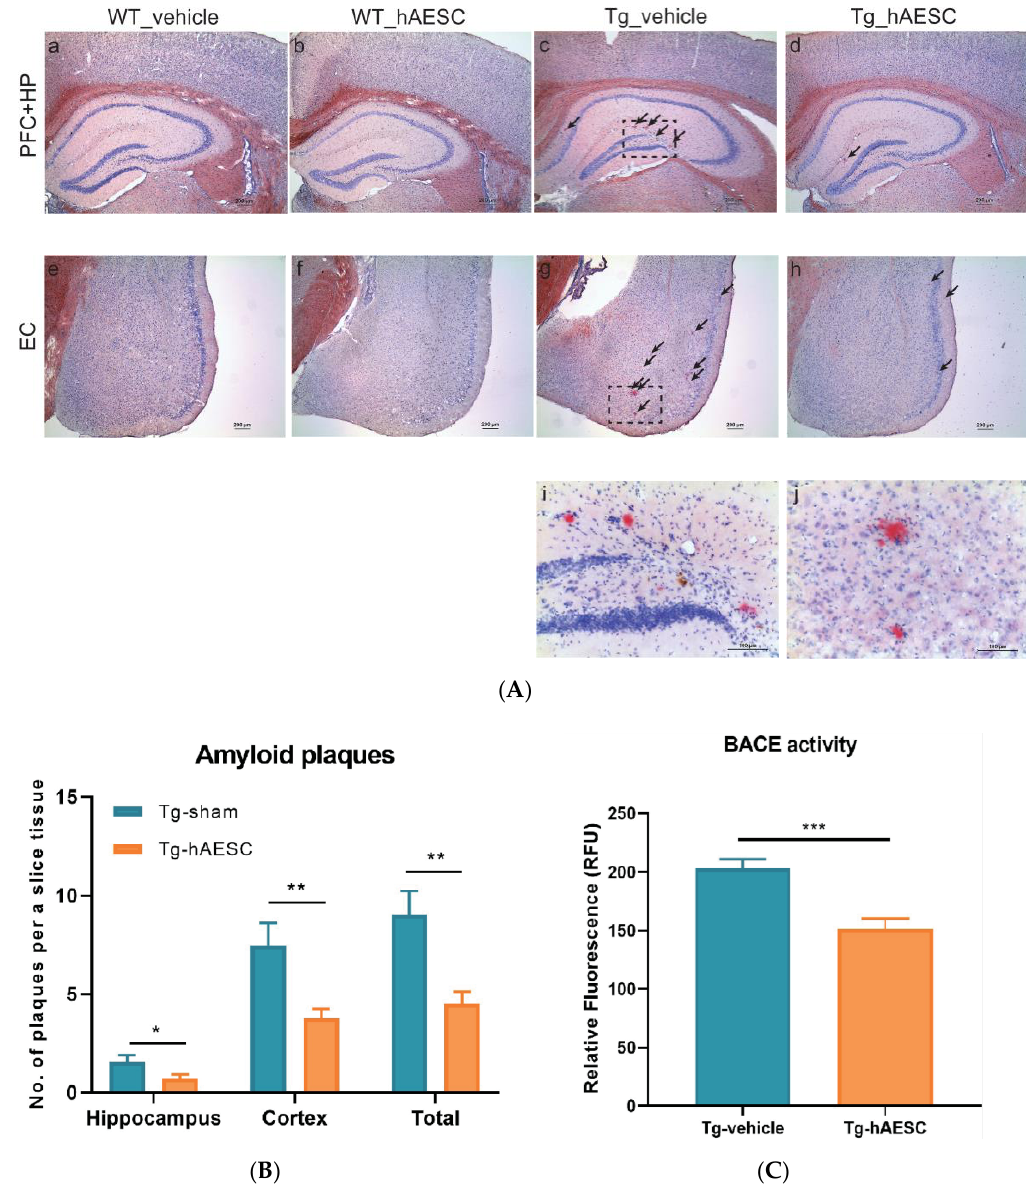
Figure 3. Effects of hAESCs injection on the number of amyloid plaques in the hippocampus and cortex of Tg2576 Alzheimer’s disease transgenic mice. ( A ) Hippocampal and cortical sections were stained with Congo red to detect amyloid plaques ( a – d : upper panel, prefrontal cortex (PFC) and hippocampus (HP), e – h : lower panel, entorhinal cortex (EC), scale bar = 200 μm). The arrows indicate Congo red-stained amyloid plaques. Square with the dotted line contains enlarged images of the brain sections of Tg-vehicle mice ( i & j ) (scale bar = 100 μm). ( B ) The number of plaques in the hippocampal and cortical regions of the Tg-vehicle and Tg-hAESC groups was counted. ( C ) BACE activity levels were analyzed 60 min after injection in the Tg-vehicle and Tg-hAESC groups. All data represent the mean ± standard error of the mean ( n = 10–15 per group). All statistical analyses were performed using the unpaired t test. * p < 0.05, ** p < 0.01, *** p < 0.001. BACE, beta-secretase; hAESC, human amniotic epithelial stem cells; Tg, transgenic.